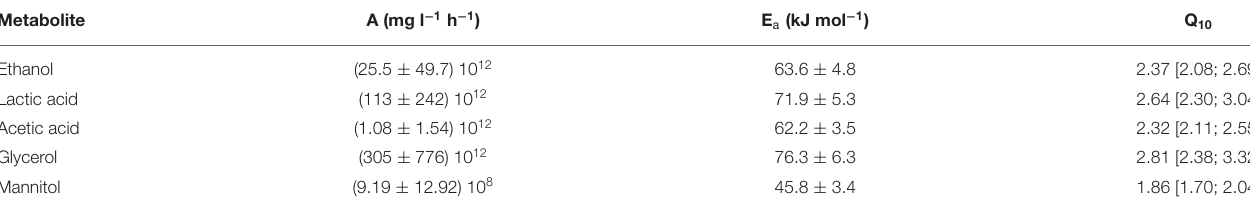
TABLE 2 | Estimated values for the pre-exponential factors (A), the activation energies (E a ), and the Q 10 values for the production kinetics of ethanol, lactic acid, acetic acid, glycerol, and mannitol during water kefir fermentation processes started with rinsed grains and incubated at 17, 21, 25, and 29 ◦ C.